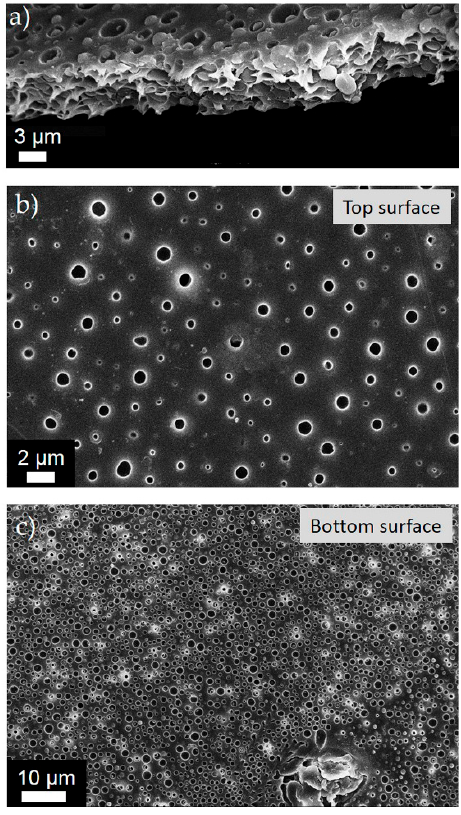
Figure 2. Representative SEM images of ( a ) cross-sectional; ( b ) top; and ( c ) bottom surface morphologies of the membrane M2-PVP6.